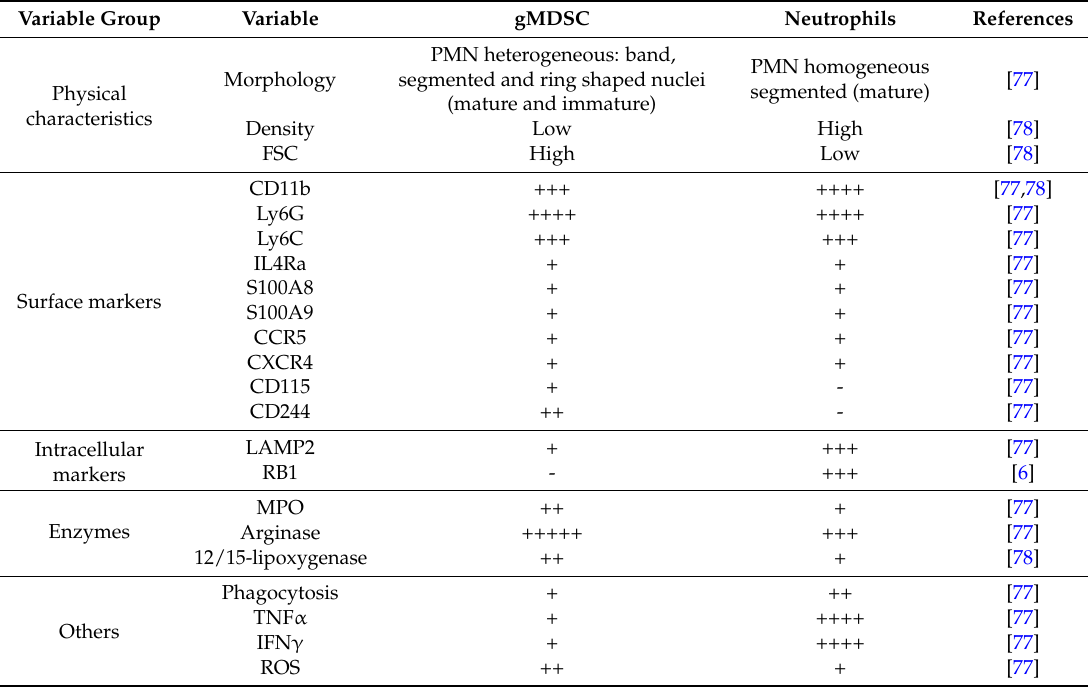
Table 1. Phenotype of gMDSCs and